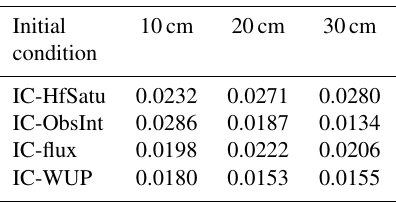
Table 4. RMSE obs results for the soil moisture predictions at ob- servation points with different initial conditions in the experimental